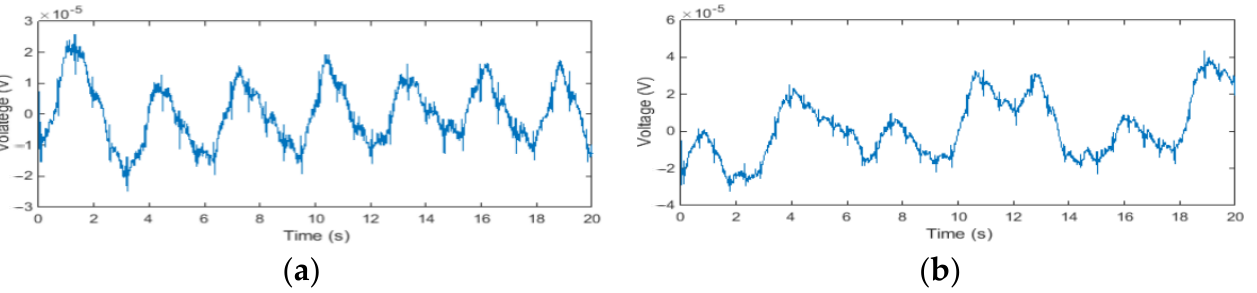
Figure 4. The analog front-end (AFE) circuit board: ( a ) schematic diagram; ( b ) circuit board.